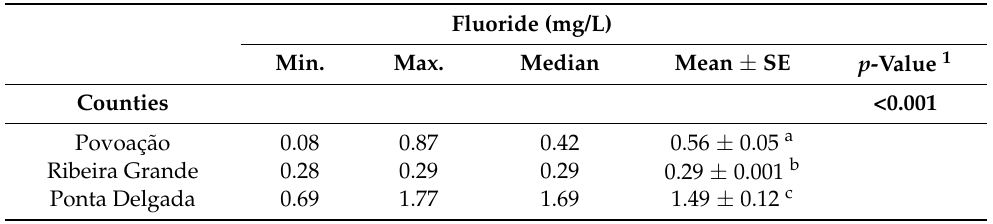
Table 1. Tap water fluoride content from the three studied counties and villages with endemic fluorosis. Fluoride concentration is presented in